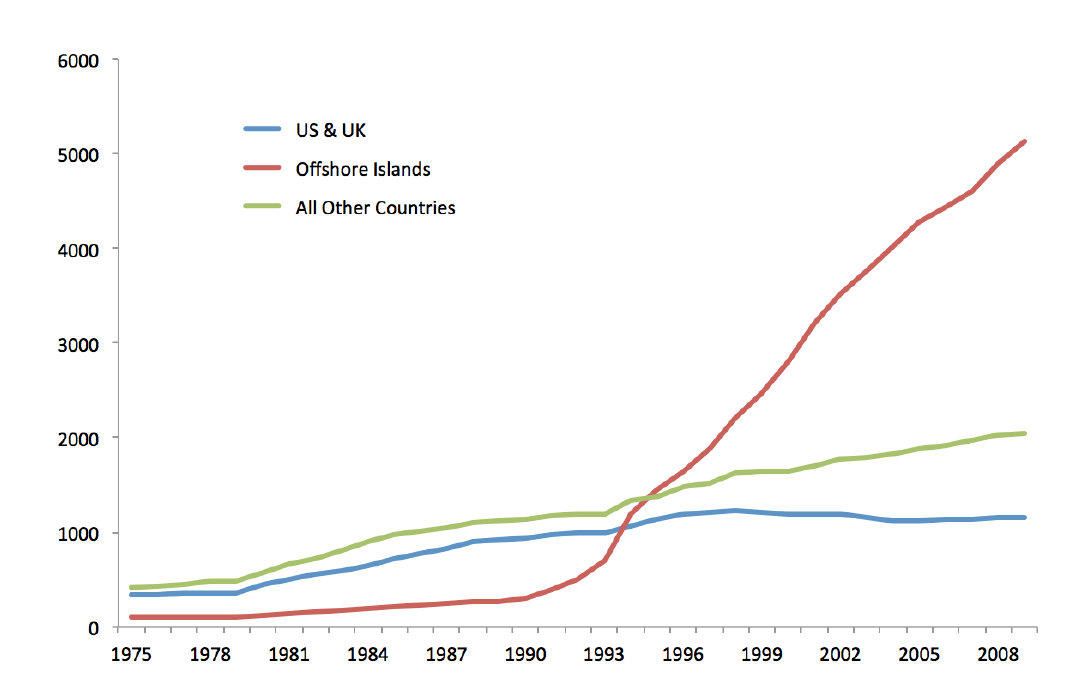
Figure 4: Total Non-local Registrations by Country of Origin (Note: Count of all other countries includes registratons from Mainland